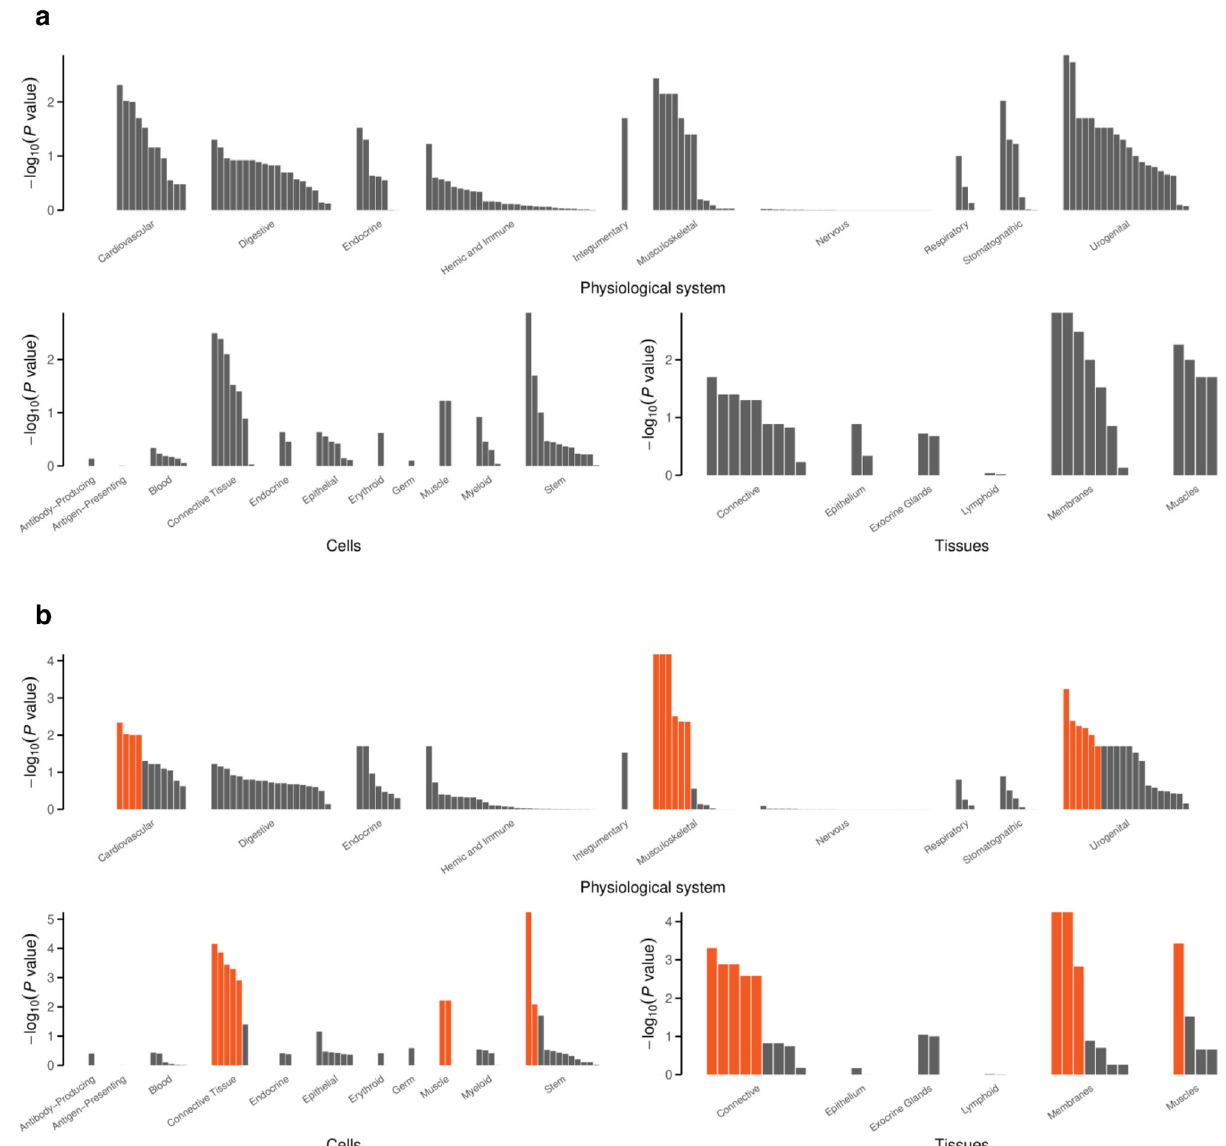
Fig. 4 DEPICT enrichment plots. Plots showing the enrichment of loci associated with a inguinal hernia and b any hernia in physiological systems, cell types, and tissues, red columns have FDR <